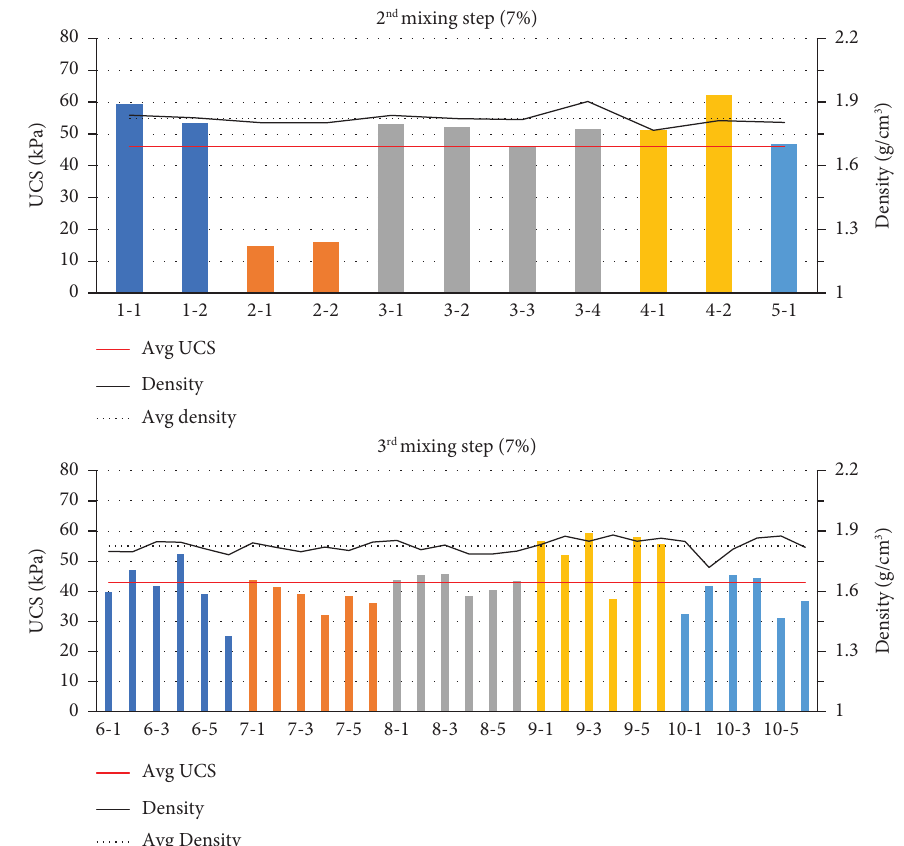
Figure 6: Phase 1: UCS results of samples taken from mixtures (28 days of curing).